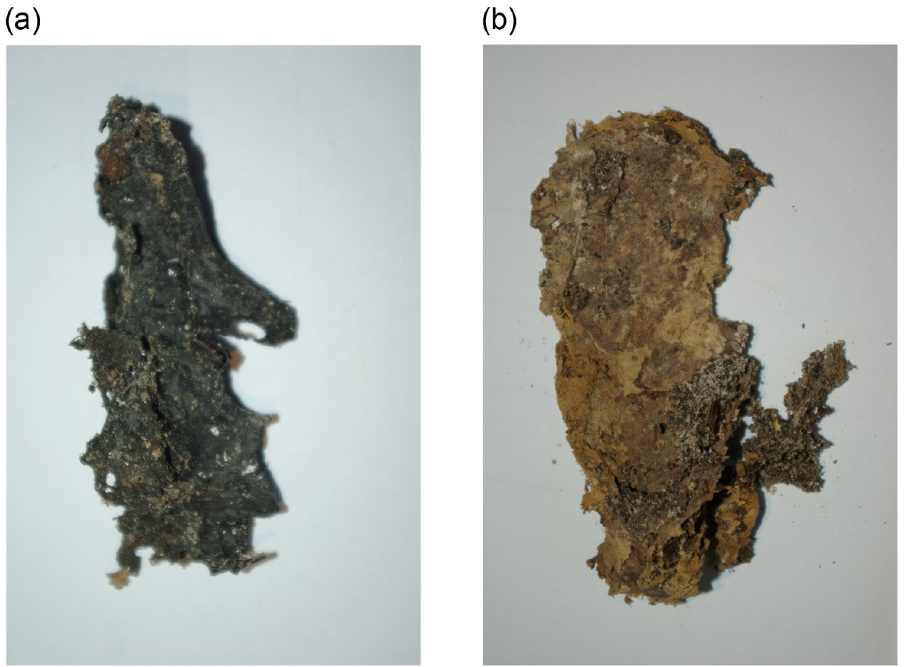
Fig 11. The autoptically removed right (A) and left (B)